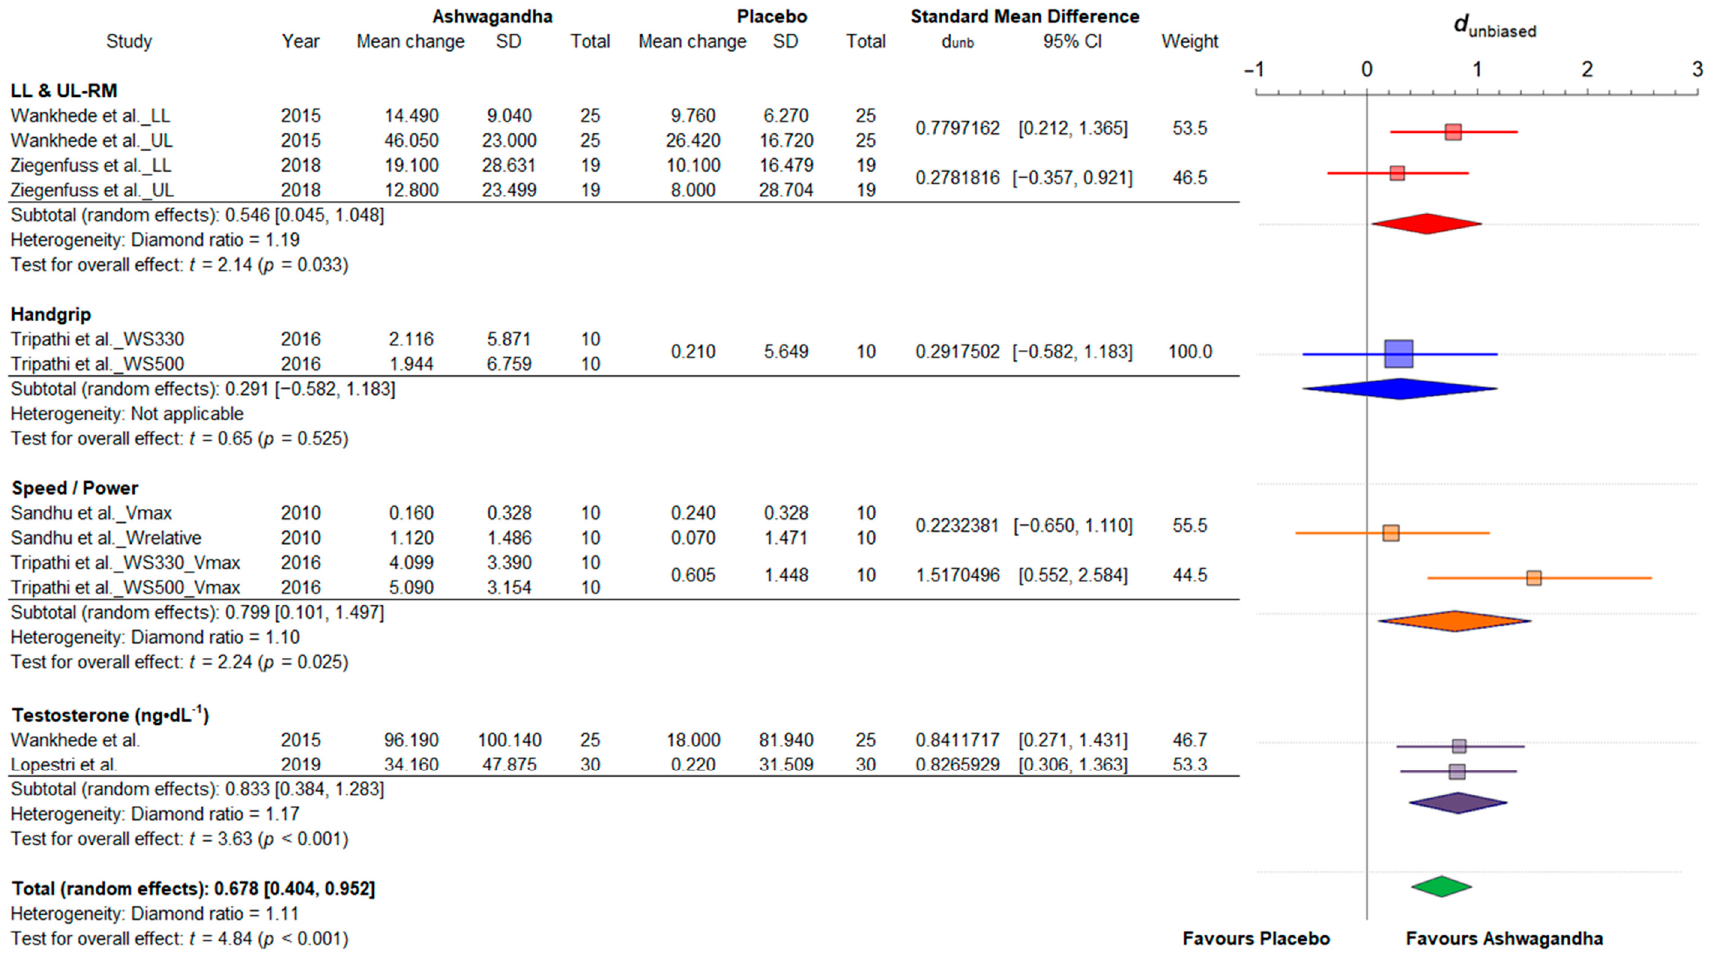
Figure 4. Forest plot depicting the standardized mean differences from the meta-analysis of studies comparing groups with Ashwagandha or placebo on strength/power. Colored squares represent the d unb for individual trials, while colored and green polygons depict the meta-analytic d unb for the indicated subgroups and for the overall (total) results, respectively. Horizontal lines represent the 95% confidence intervals for the data. LL: lower limbs; RM: one-repetition maximum (kg); UL: upper limbs; Vmax: maximum velocity (m·s − 1 ); Wrelative: relative power (W·kg − 1 ); WS330: Withania somnifera 330 mg; WS500: Withania somnifera 500 mg.